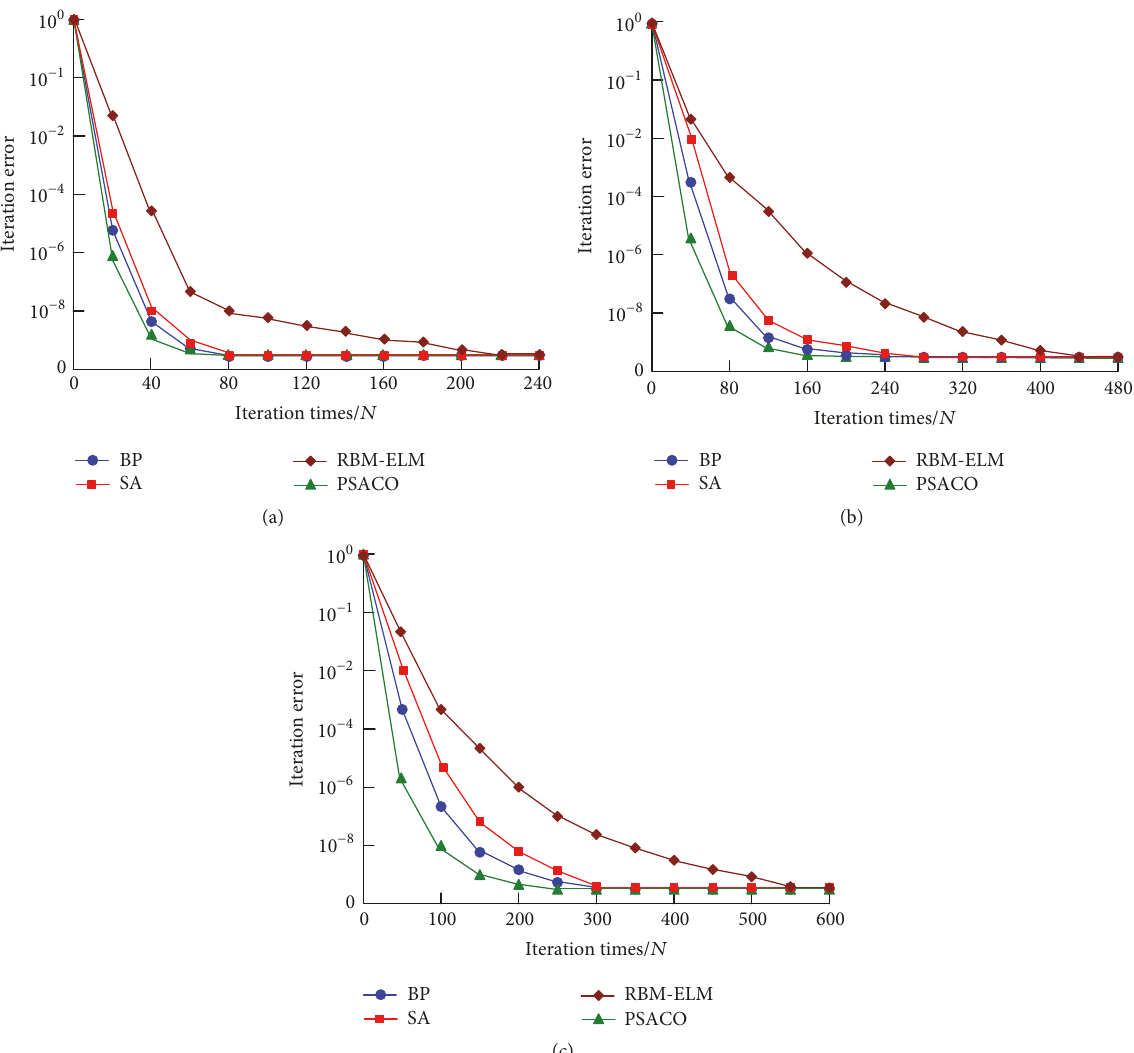
Figure 4: Clustering comparative results with the BP, SA, and RBM-ELM algorithms for CNIS-I: (a) original sample, convergence iteration times: 60, 71, 79, 223; (b) damaged sample, convergence iteration times: 163, 185, 206, 442; (c) transformed sample, convergence iteration times: 213, 275, 300,